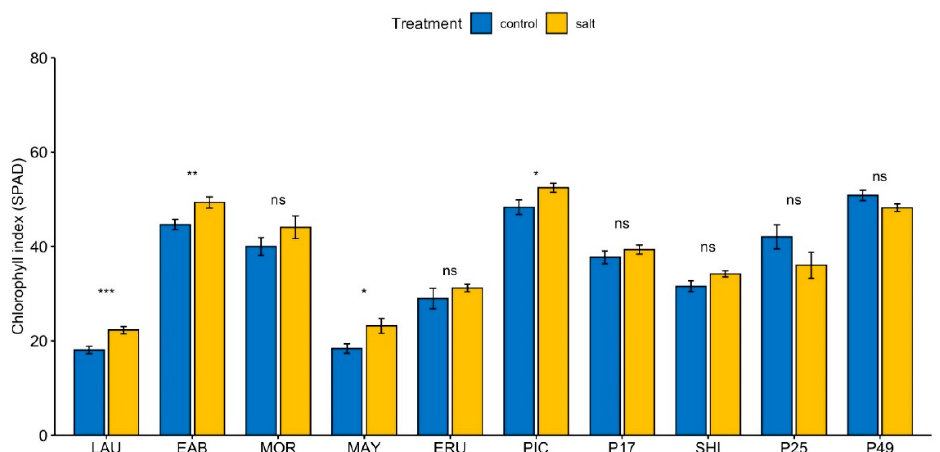
Figure 2. Effect of salinity on chlorophyll index in lettuce leaves. The chlorophyll index (SPAD) was measured from the same relative area from five leaves of similar age from each plant and averaged for one reading. Values are means of five independent experiments, each with at least four biological replicates per cultivar / accession per condition. Bars represent standard errors; asterisks indicate statistical significance as calculated by the t -test. * ( p ≤ 0.05), ** ( p ≤ 0.01), *** ( p ≤ 0.001), **** ( p ≤ 0.0001), ns = not significant ( p > 0.05).